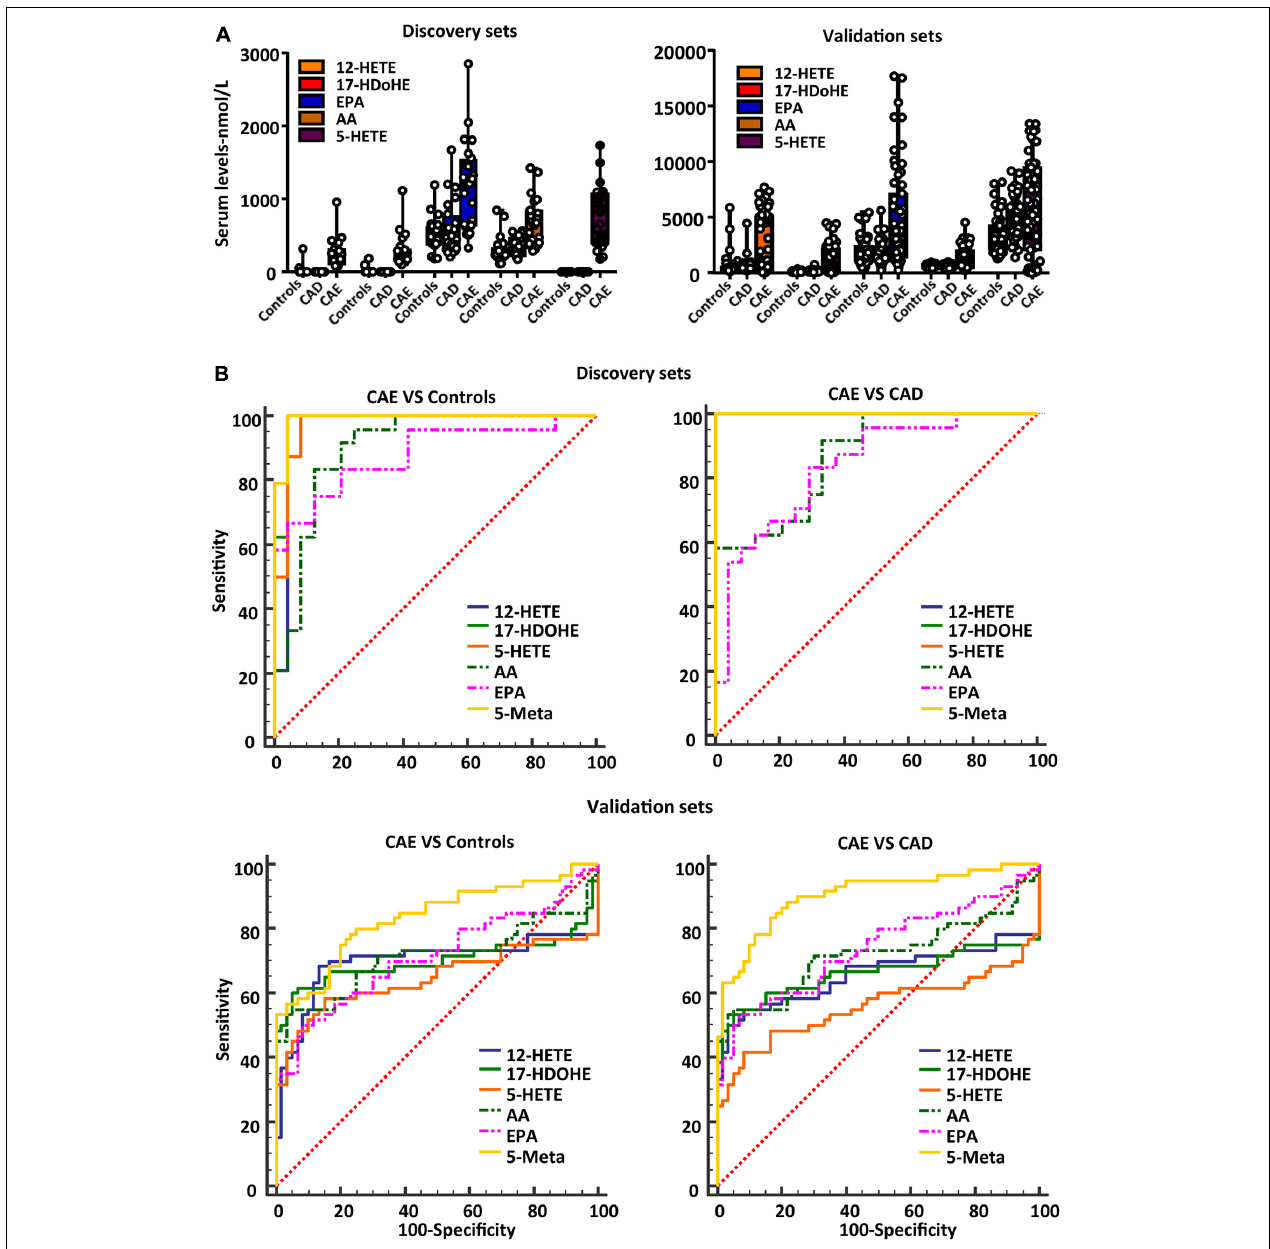
FIGURE 4 | Validating the diagnostic performance of the biomarker panel for CAE. (A) Serum concentrations of a defined biomarker panel in the discovery and validation sets. (B) ROC curves of biomarker panel and signal metabolites in discovery sets and validation sets. CAE, coronary artery